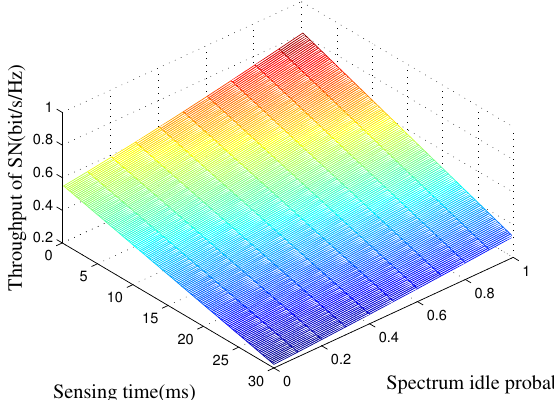
Figure 4. SN’s average throughput of the proposed strategy as a function of the spectrum sensing time and spectrum idle probability. The transmit power of the BS is set to P p = 15 dB, and the target secure outage probability is set to P th = 0.1.